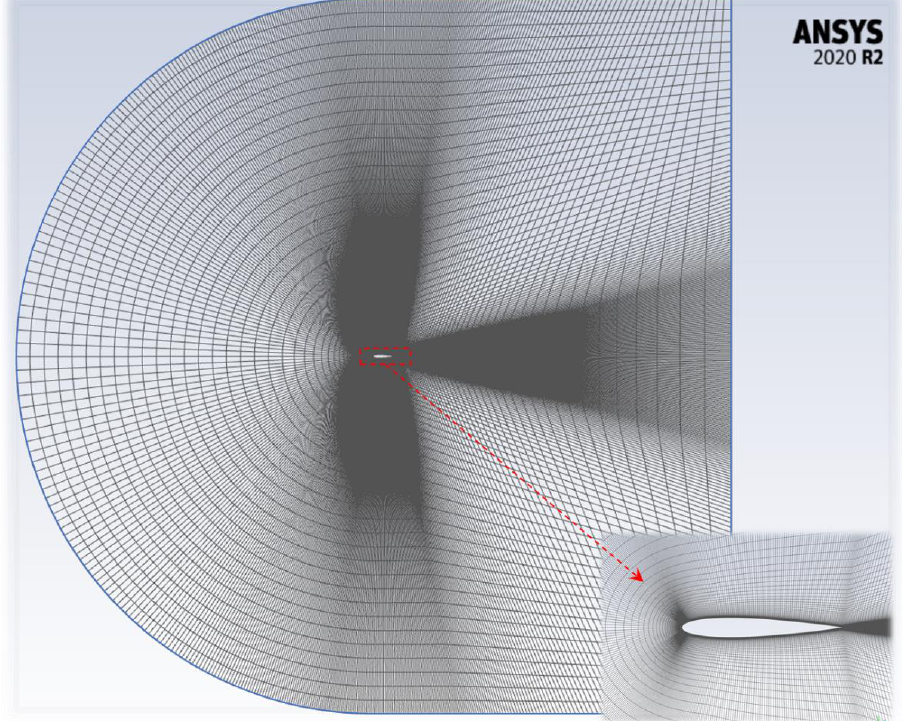
Figure 4. A structured grid representation by ANSYS FENSAP-ICE for icing simulation around a NACA 0012 symmetric airfoil. @Fahed Martini.